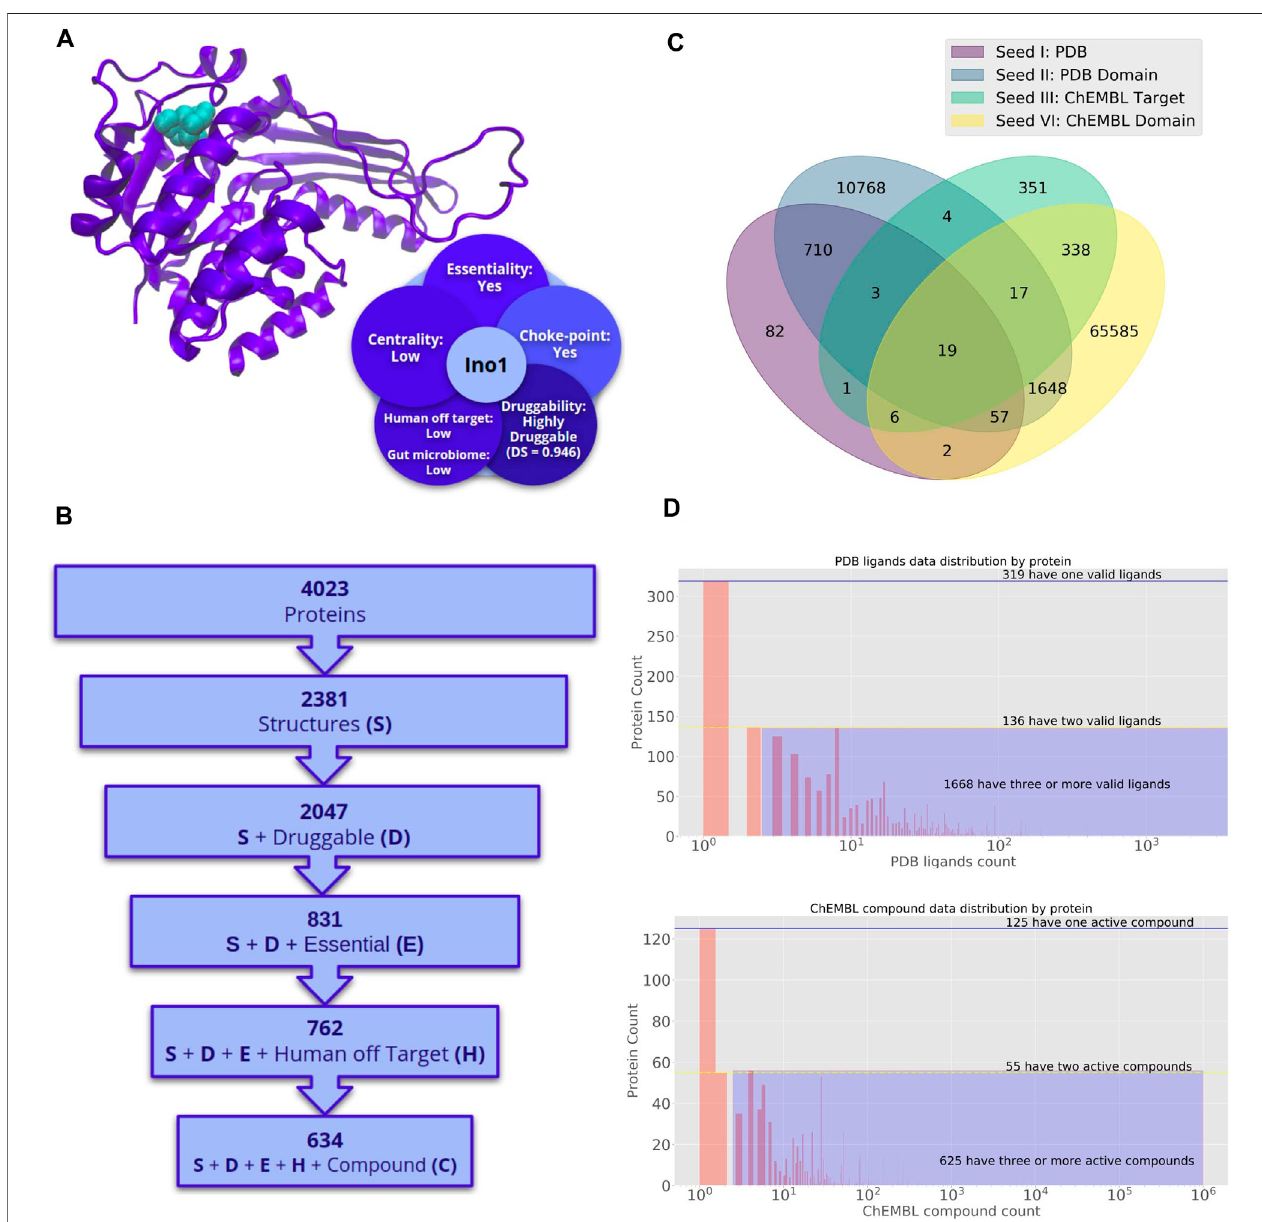
FIGURE3| Potentialdruggabletargets and putative leadcompounds tocombat Mycobacterium tuberculosis . (A) Inositol-3-phosphate synthase (Ino1)structure. Crystallographicstructureandasetofattractivefeaturesfortargetprioritizationareshown. (B) Numberofproteinsin Mycobacteriumtuberculosis genomewithdesirable propertiesfordrugtargets. Different fi ltersaresequentiallyapplied toobtainashortlistofdruggable,essential,andlowidentitieswithproteinsinthehumangenome.The last fi lter is applied to get the list of proteins with putative binders (C) Seed Compounds for Mycobacterium tuberculosis . Venn diagram of the number of seed compounds corresponding to different sets. Binders are classi fi ed in groups according to the degree of protein similarity [starting from high identity > 60% homologs to binders to the same domain in PFAM (Mistry et al., 2020)] and available information (such as the structure of the protein-ligand complex) in different databases such as Protein Data Bank (PDB), Pfam, ChEMBL (EMBL-EBI). Venn diagram of the number of seed compounds corresponding to different sets. Binders are classi fi ed into two seed groups. Seed I and III are obtained through the direct search of the protein of interest by its corresponding identi fi er (ID) for each base and ChEMBL. Seed II are thosedrugsthatbindanyprotein thatharborthesamePfamdomainswithBbproteins andhavebeenco-crystallizedwithsuch proteinsinthePDB.SeedIVisthesetof drugsthatbindanyproteinthatsharesPfamdomainswith Mycobacteriumproteins andwasreportedasactiveinChembl. (D) Numberofproteinsinthe Mycobacterium tuberculosis genome for which a ligand can be predicted. The top panel corresponds to drugs in Seed II. The bottom panel corresponds to drugs in Seed IV.